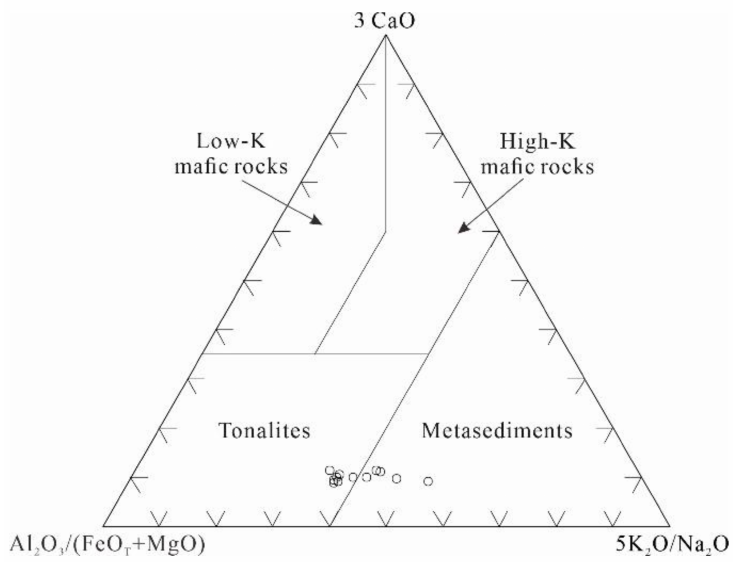
Figure 12. Ternary diagram for distinguishing the potential sources of